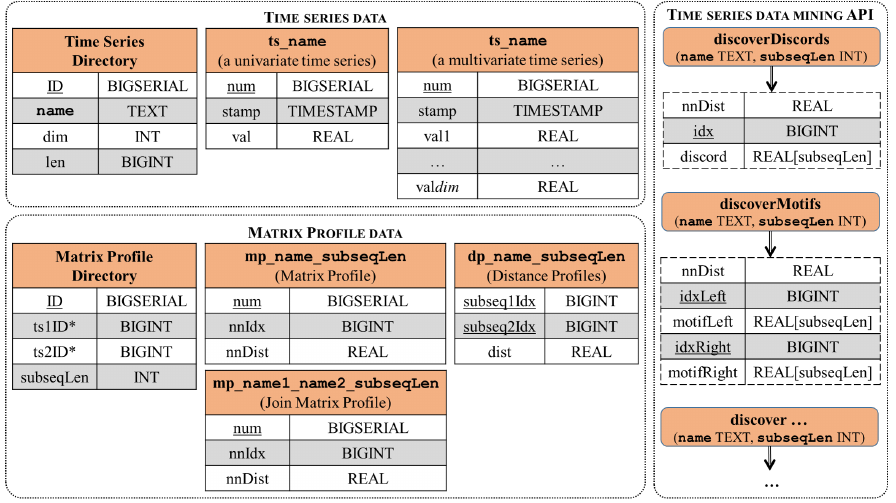
Figure 12. Database structure to manage Matrix Profile in